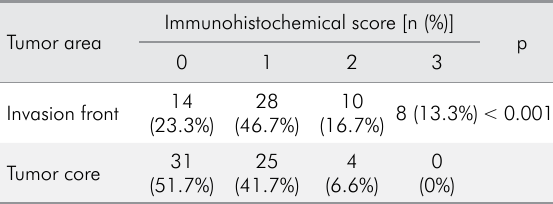
Table 3. Immunohistochemical scores of uPAR according to the tumor area.